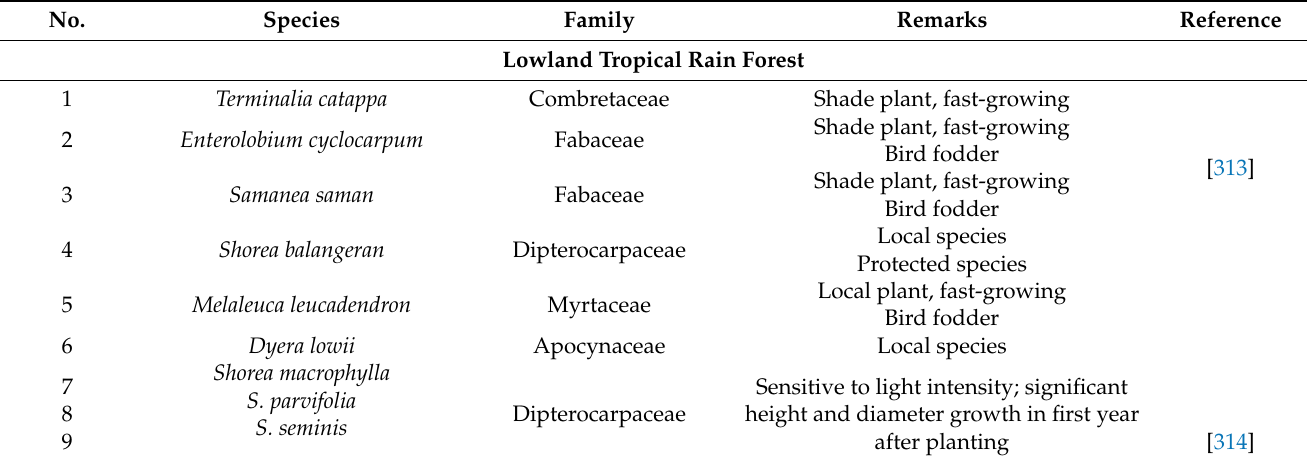
Table 6. Plant species employed in tropical forest restoration in